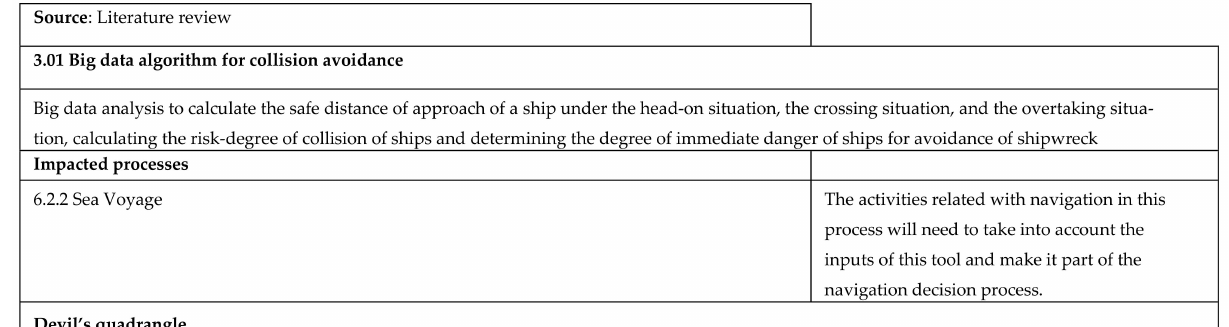
Figure A27. Cont